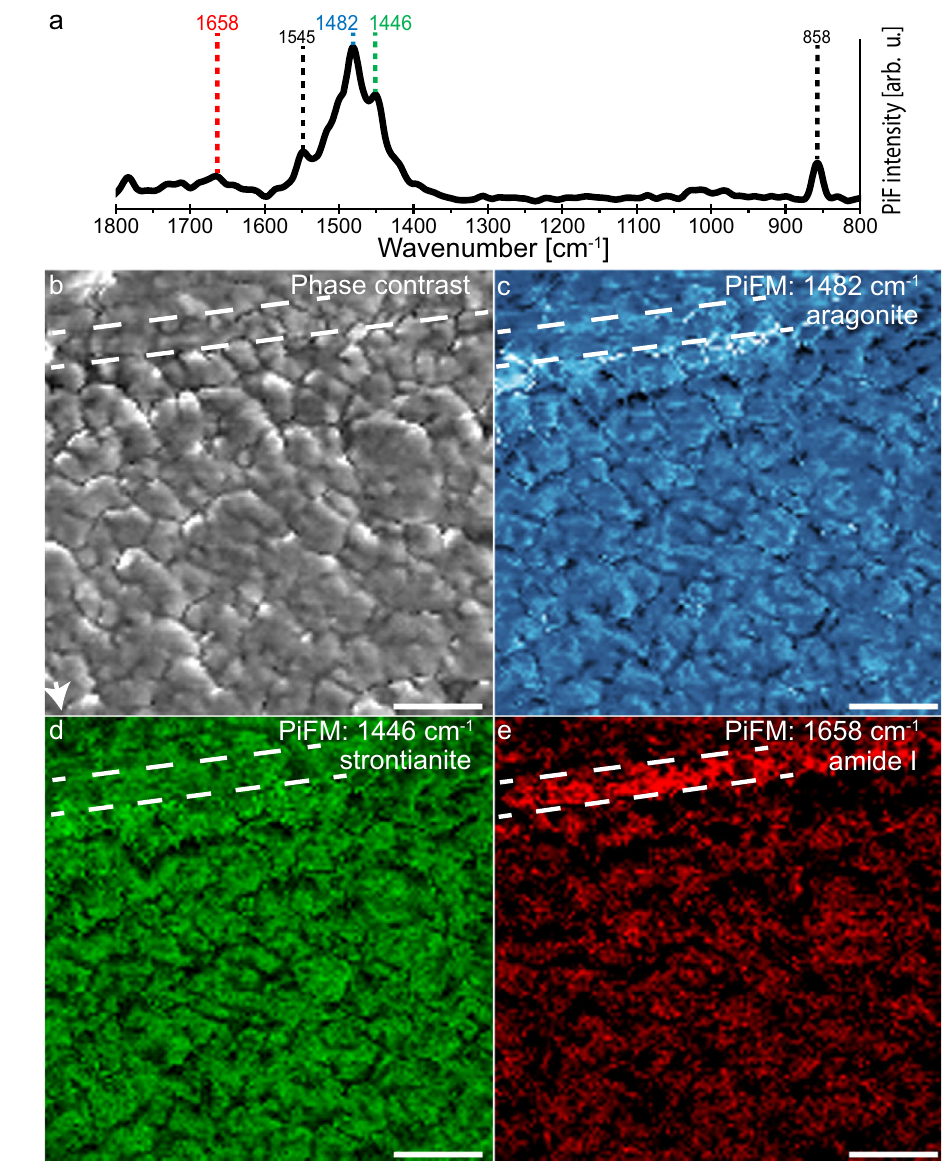
Fig. 5 | PiFM analysis revealing heterogeneous, nanoscale phase distributions in Sr-labelled nacre. a Representative PiFM spectrum showing the absorption bands chosen for extracting the colour-coded PiFM phase distribution maps at 1482, 1446 and 1658cm − 1 as well as additional bands characteristic of aragonite (black font). b The 0.5×0.5 µ m AFM phase contrast map was simultaneously acquired with the PiFM phase distribution maps obtained from Sr-labelled nacre (specimen:M2S2R)withtheinterlamellarorganicsheet(withinwhitedashedlines) running nearlyhorizontally through the mappedregion. Lighterand darkercolour in the phase contrast map highlight the space- fi lling nanogranular texture; the whitearrowpointstowardsthedirectionofextensionalnacregrowth(i.e.,theinner